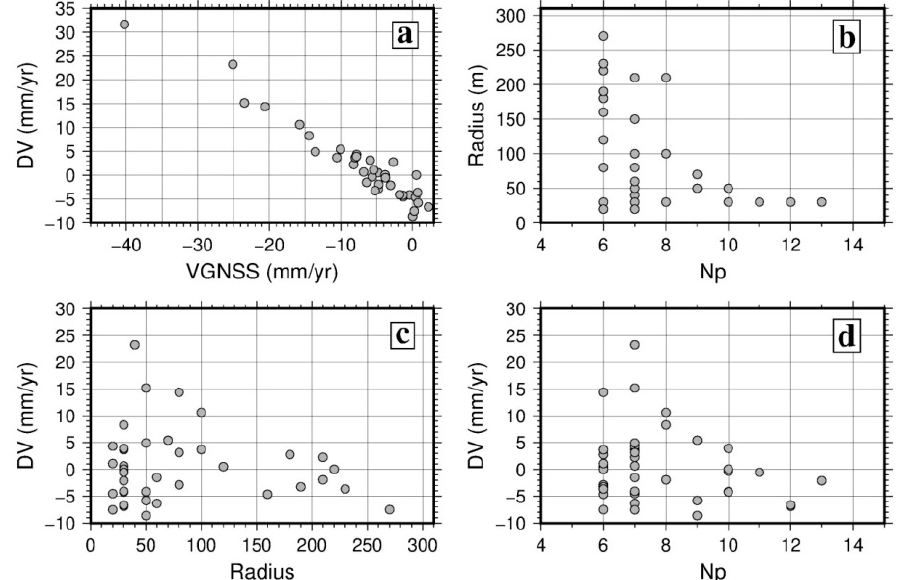
Figure 7. Comparison between the InSAR and GNSS velocities; ( a ) The differences DV (V InSAR − V GNSS ), in mm/year, between the interferometric and GNSS velocities; ( b ) The InSAR velocities were calculated averaging at least the rates of 6 points located at distances less than the radius. The figure shows the minimum radius needed to find at least 6 points in the searched area; ( c ) differences DV (V InSAR − V GNSS ), in mm/year, between the rates compared to the radius used to obtain the InSAR velocities; ( d ) differences DV (V InSAR − V GNSS ), in mm/year, compared to the number of points (Np) used to estimate the interferometric rates.